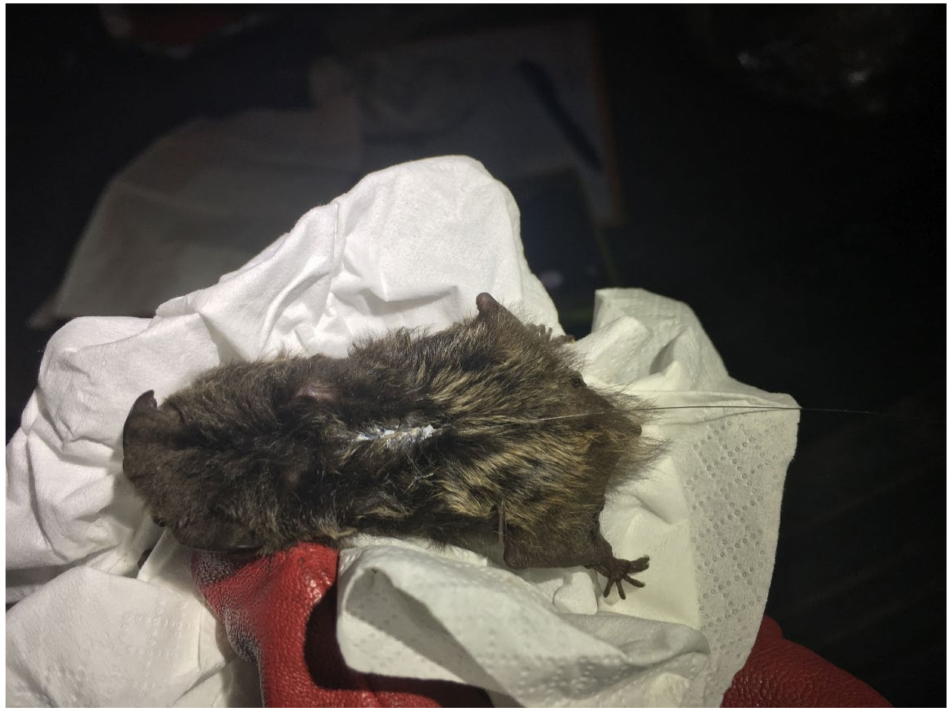
Figure 2. Western barbastelle female tagged with radio transmitter Holohil LB2, ready to release (photo A.